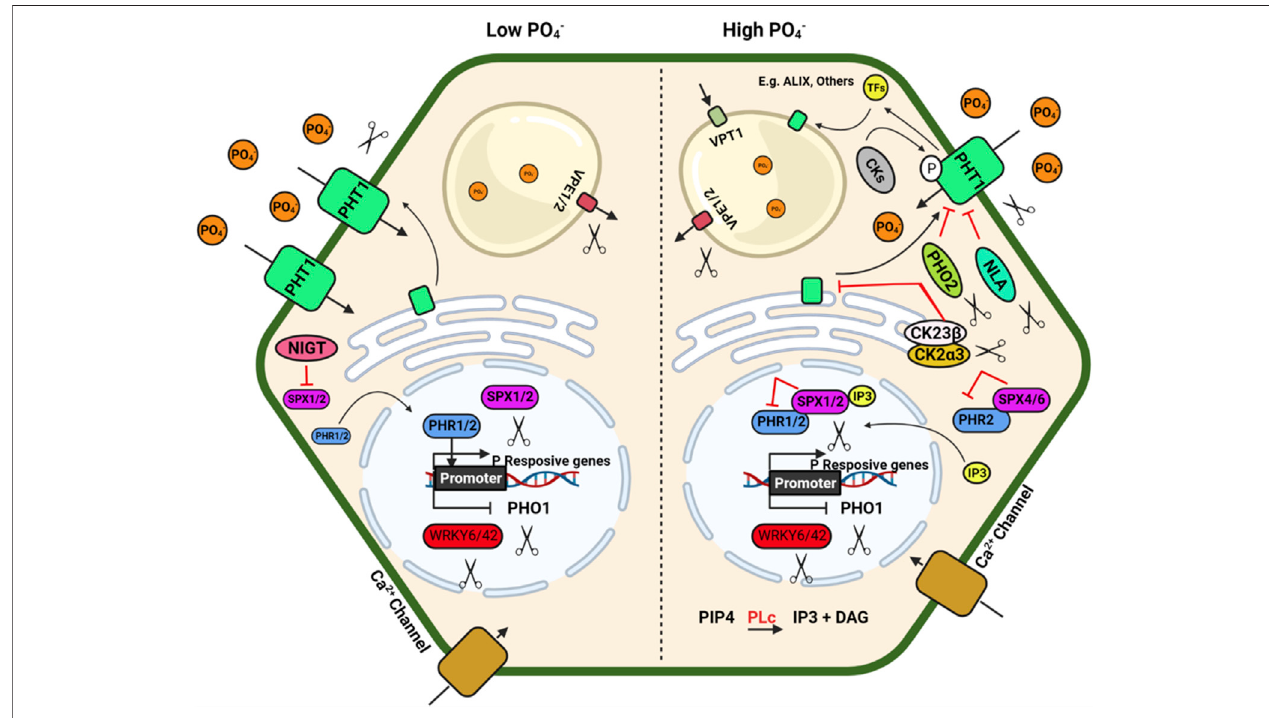
FIGURE2| Schematicmodeldepictingplantresponsetophosphorusavailabilityandsignaling.IllustrationwasmadewithBiorender(https://biorender.com/).The negative regulators for targeted genome editing are indicated with a scissor sign.